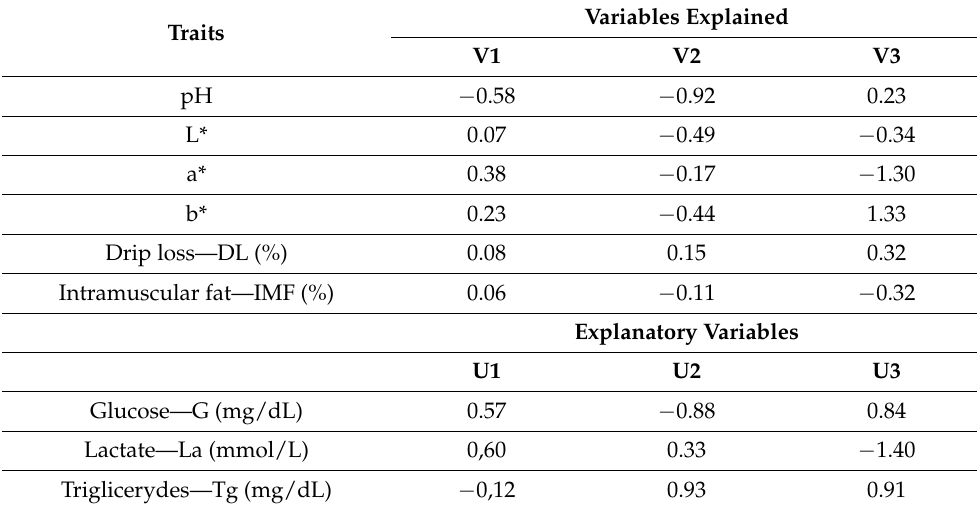
Table 4. The results of the canonical analysis: canonical weights.